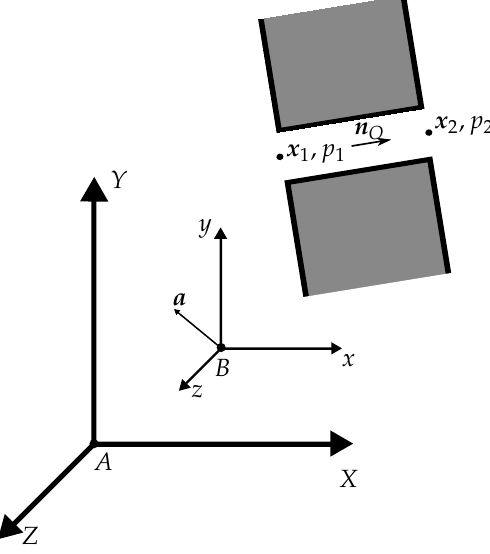
Figure 3. Orifice within non-inertial reference frame